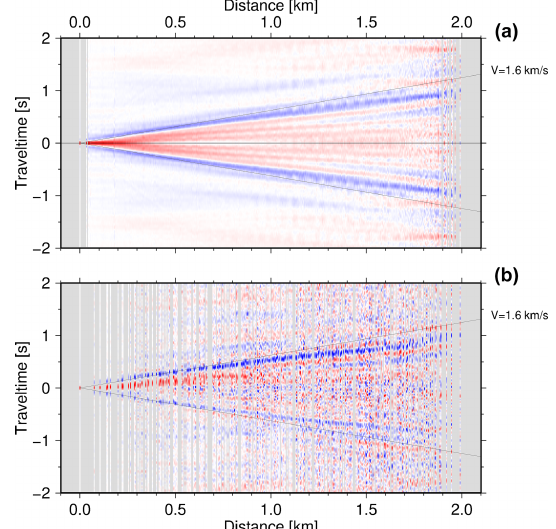
Figure 4. Cross-correlations of the vertical component data of all stations (a) against each other sorted by distance in order to evaluate the data quality. The ambient noise technique allows the Green’s function for station pairs to be recovered from the recorded ambient noise. A stack of all unfiltered Green’s functions is shown, stacked in offset (distance between stations) bins. Surface waves are clearly identified and dominate this record section (red/blue bands starting at zero distance). Panel (b) shows the virtual shot gather between the westernmost station (001) against all other stations. The strong asymmetry between the causal and acausal phases is caused by the non-uniform distribution of noise